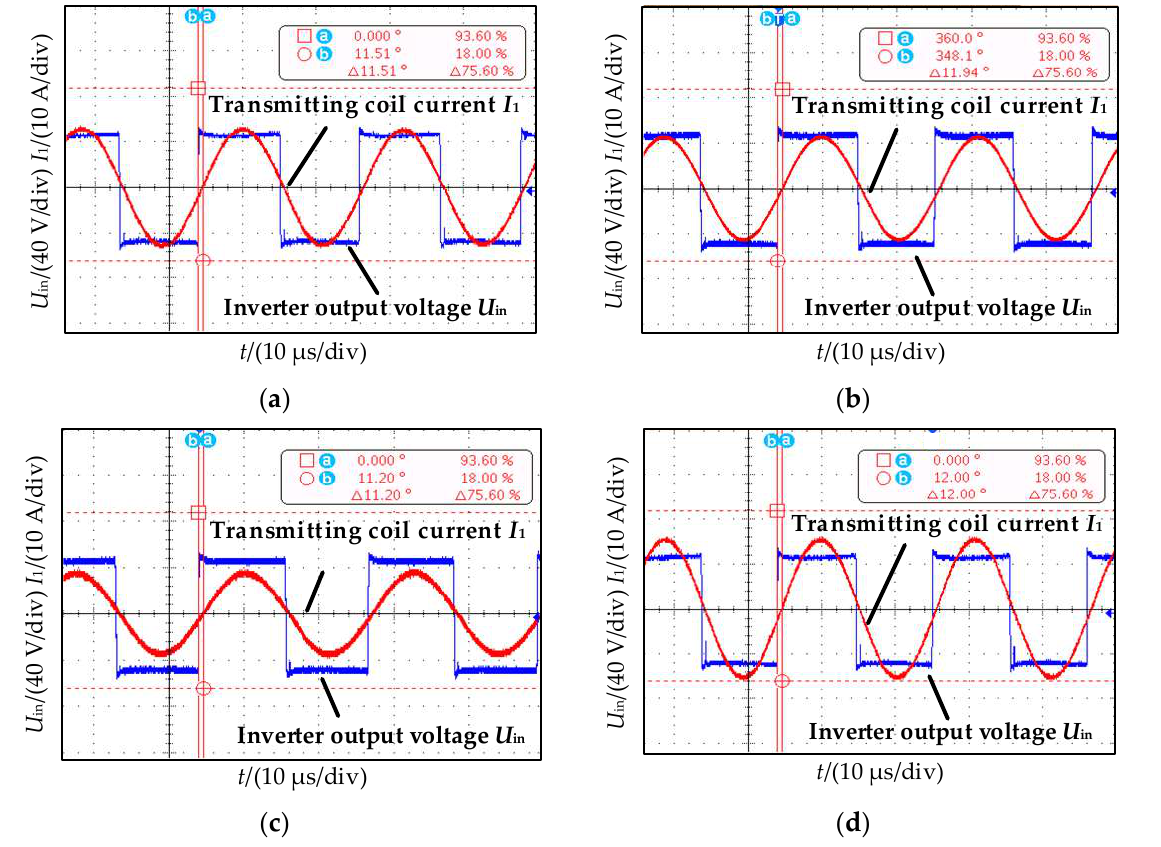
Figure 15. Voltage and current phase diagram based on frequency-tracking method: ( a ) R L = 5 Ω, coil distance of 24 cm; ( b ) R L = 15 Ω, coil distance of 24 cm; ( c ) R L = 7 Ω, coil distance of 18 cm; ( d ) R L = 7 Ω, coil distance of 28 cm.